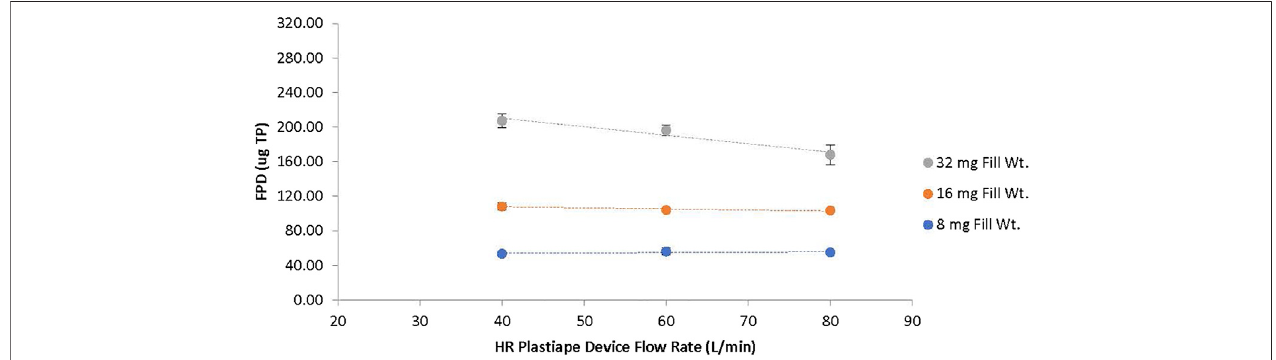
FIGURE5| TPFineParticleDose(FPD)asafunctionofDeviceResistanceandTPIPCapsuleDosefortheHRDevice.ThedottedlinesshowthechangeinFPDforthe 8 mgcapsuledose(blue),16 mgcapsuledose(orange),and32 mgcapsuledose(gray)asafunctionof fl owratewiththehighresistancedevicetestedat40,60and80LPM.